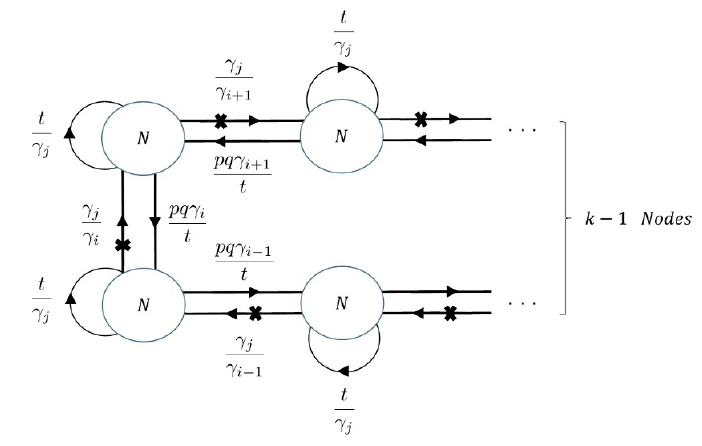
Figure 8 . Toric quiver obtained by gluing two maximal punctures of the free trinion and closing the minimal